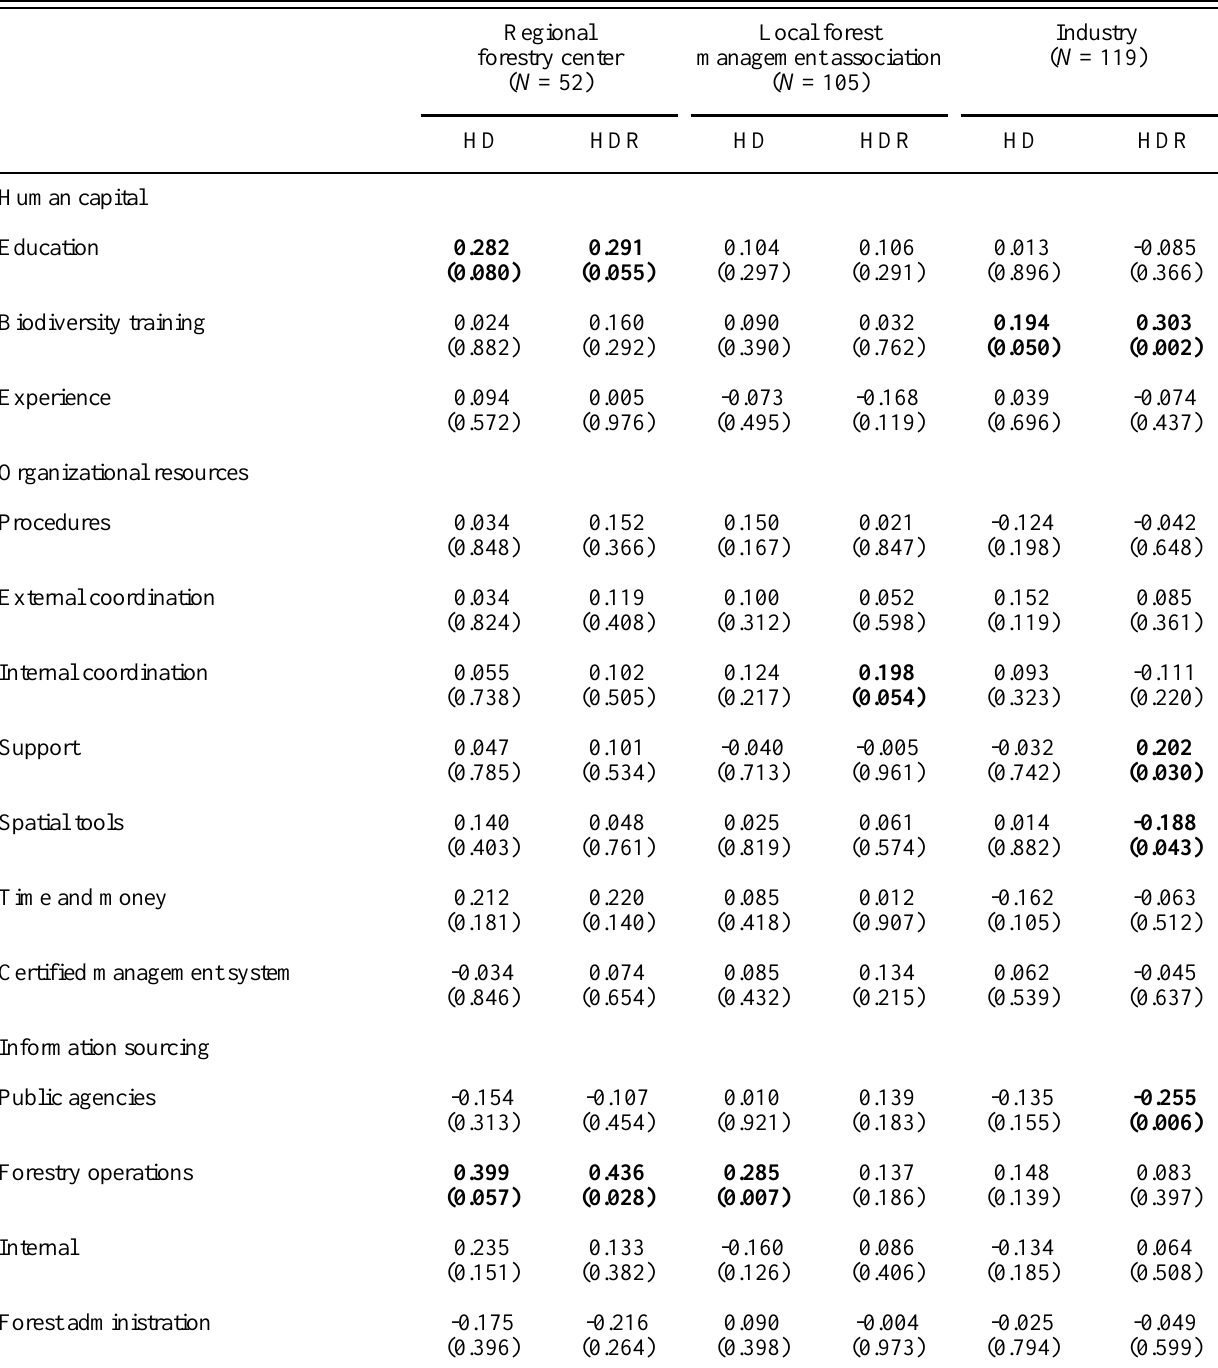
Table 5 . Regression analyses of competencies on respondents’ delineation and delineation rate (log transformed) in three organization types: standardized beta and significance in parenthesis. Bold values are significant at P > 0.1. HD stands for habitat delineation and HDR for habitat delineation